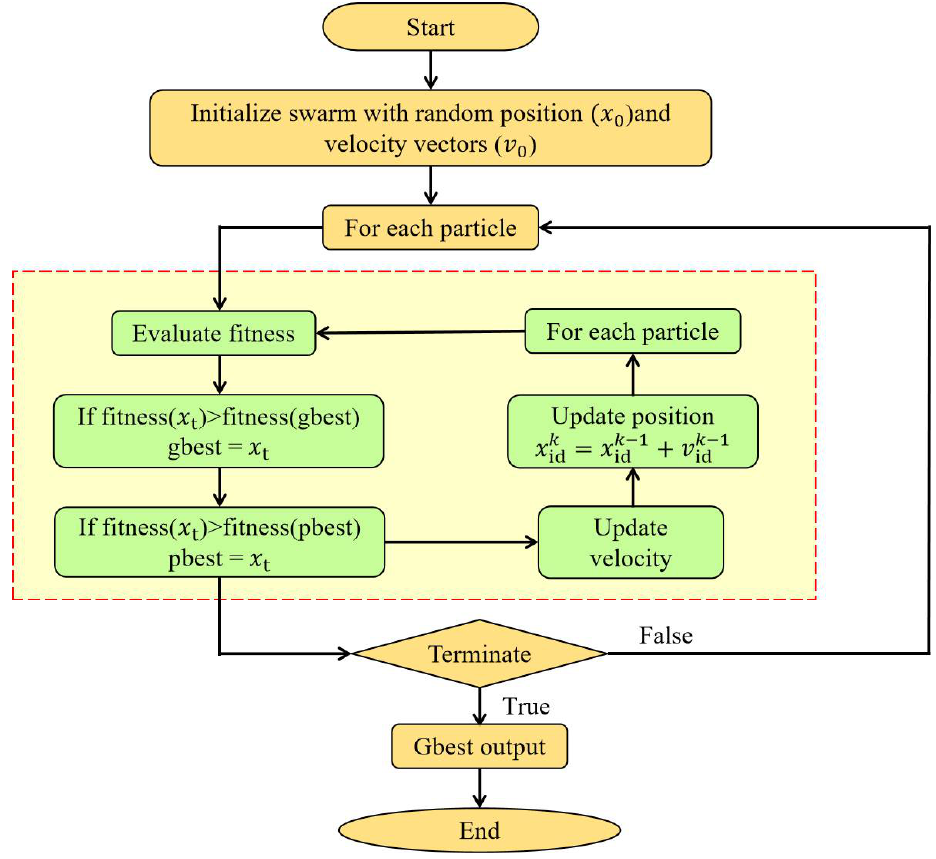
Figure 3. Overall flowchart of the PSO algorithm.